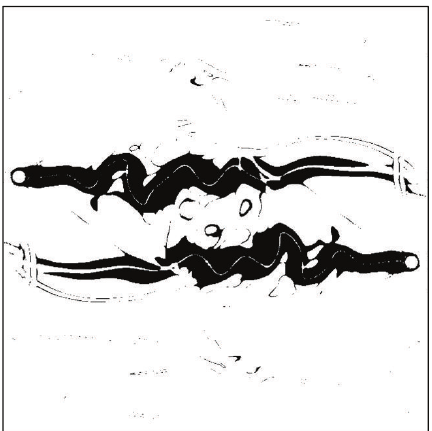
Figure 21: Visualization of switching parameter 𝛽 at 𝑡 = 23.2 with 𝑑𝑥 = 0.025 𝐷 .